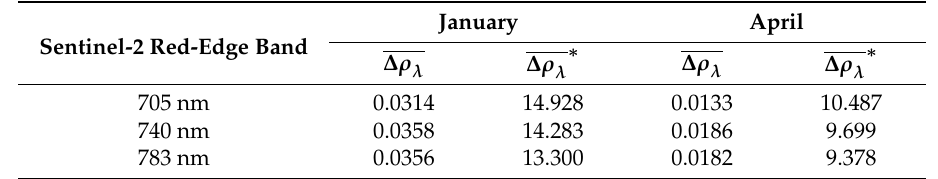
) (Equation (5)) and mean absolute relative Table 5. Mean absolute reflectance differences ( ∆ ρ λ ∗ ) (Equation (6)) between the pairs of forward and backward scatter percentage differences ( ∆ ρ λ Sentinel-2A surface reflectance values illustrated in Figures 4 and 5. A total of 6,600,685 and 10,656,197 pairs of forward and back scatter surface reflectance values were considered in January and April, respectively.